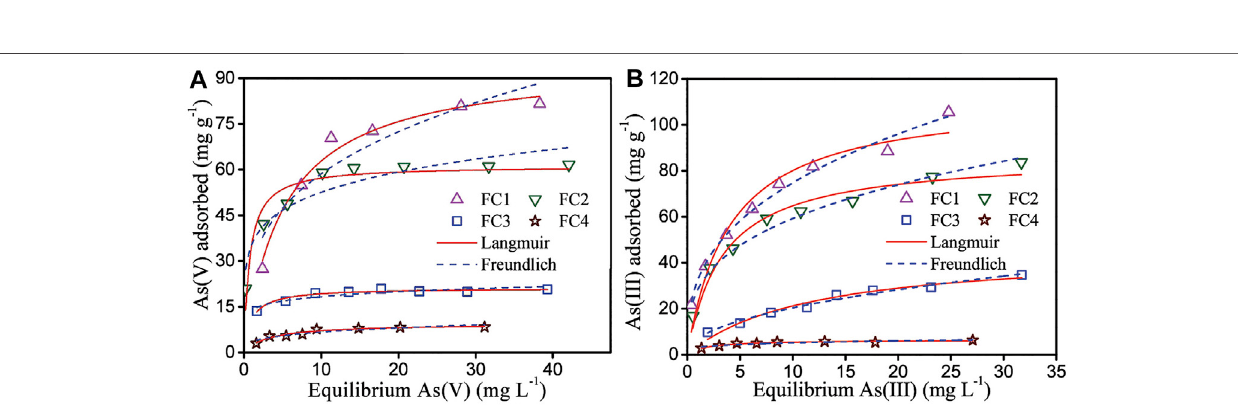
Frontiers in Chemistry |